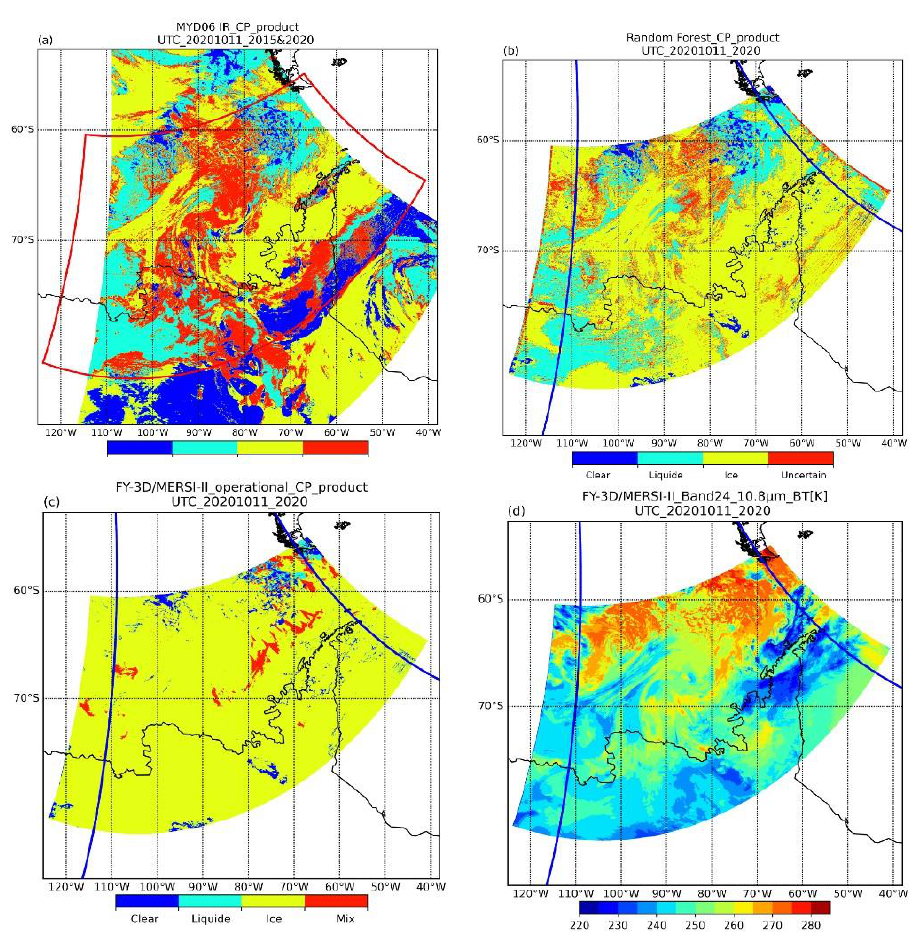
Figure 8. Comparisons of CP products for high latitudes on 11 October 2020 for ( a ) the MODIS CP product at 20:15 and 20:20 UTC, ( b ) the RF CP product at 20:15 UTC, ( c ) the operational FY-3D/MERSI-II CP product at 20:15 UTC, and ( d ) the FY-3D/MERSI-II band 24 BT image at 20:15 UTC. The red box is the outline of the 20:15 UTC FY-3D image, and the blue box is the contour of the 20:15 and 20:20 UTC Aqua images.